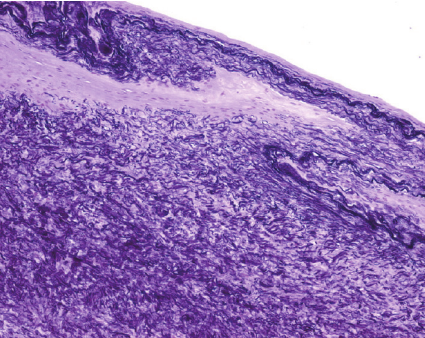
Figure 6: Histopathology: hematoxylin-eosin stain, magnification 100x.